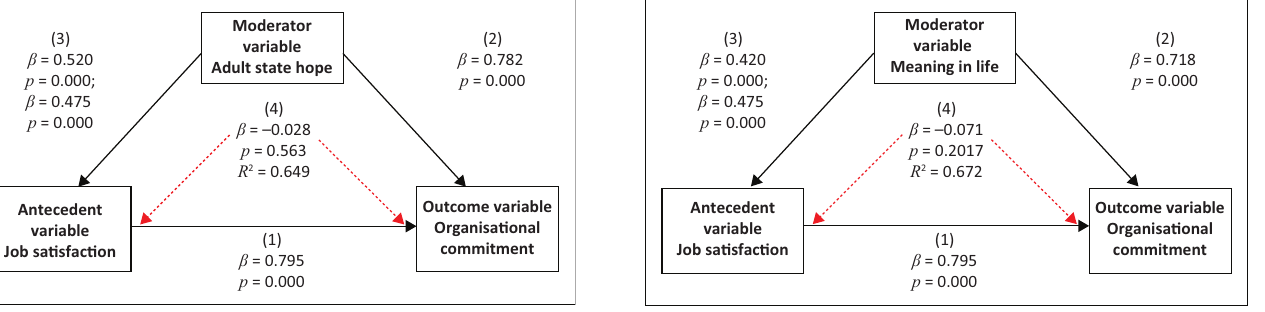
FIGURE 3: Moderation analysis between job satisfaction, meaning in life and organisational